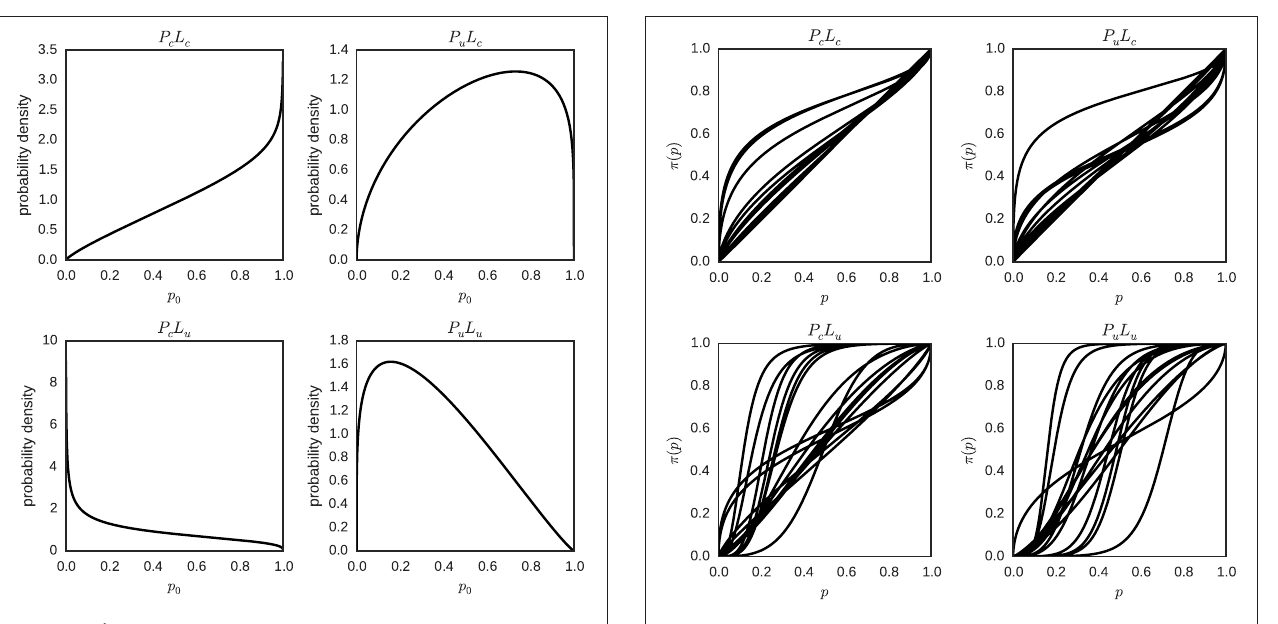
FIGURE 12 | Individual probability weighting functions using the posterior mean for γ and p 0 in the hierarchical model for the different conditions ( P c L c , P u L c , P c L u and P u L u ). Each plot represents one condition, and each line represents the best estimate obtained for the weighted probability function for one individual in that